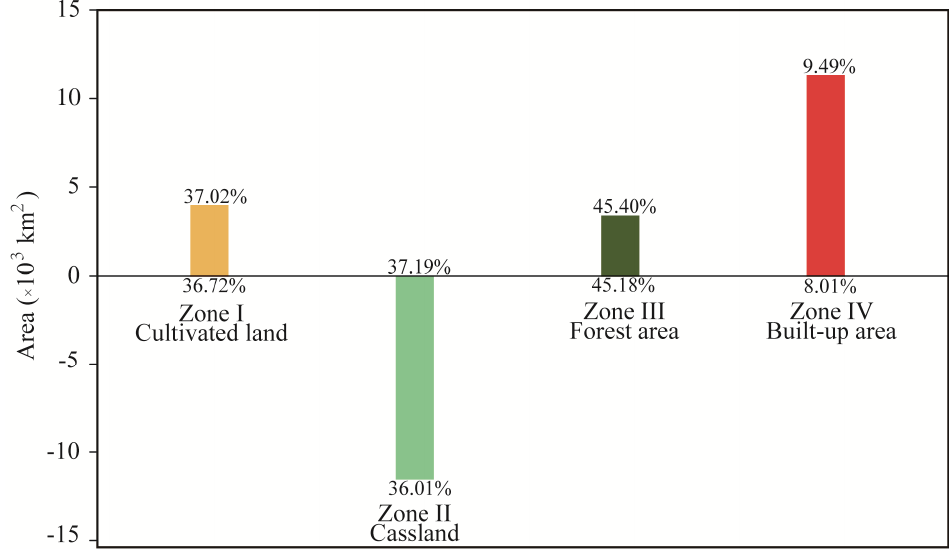
Figure 2. Area and percentage of dominant land use and land cover in each